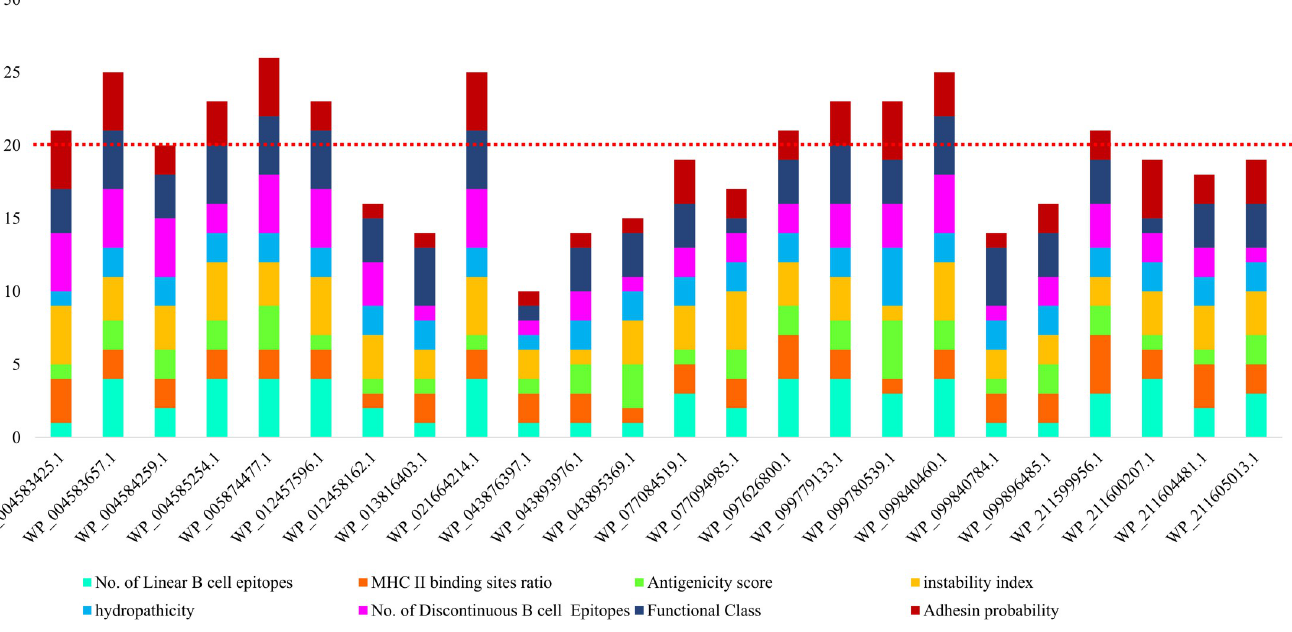
Fig 4. The comparative analysis of putative immunogenic targets against P . gingivalis based on quartile scoring method. Twelve proteins with a score � 20 were selected: WP_005874477.1 (26), WP_004583657.1 (25), WP_021664214.1 (25), WP_099840460.1 (25), WP_004585254.1 (23), WP_012457596.1 (23),